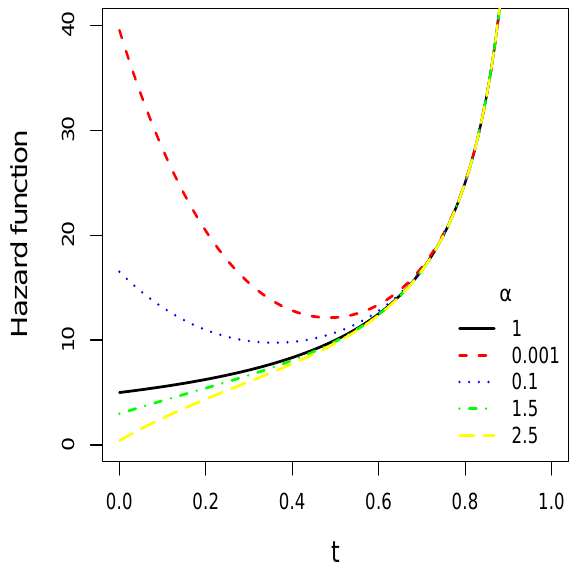
Figure 2. Some LPHU hrf curves for β = 5 and different values of α